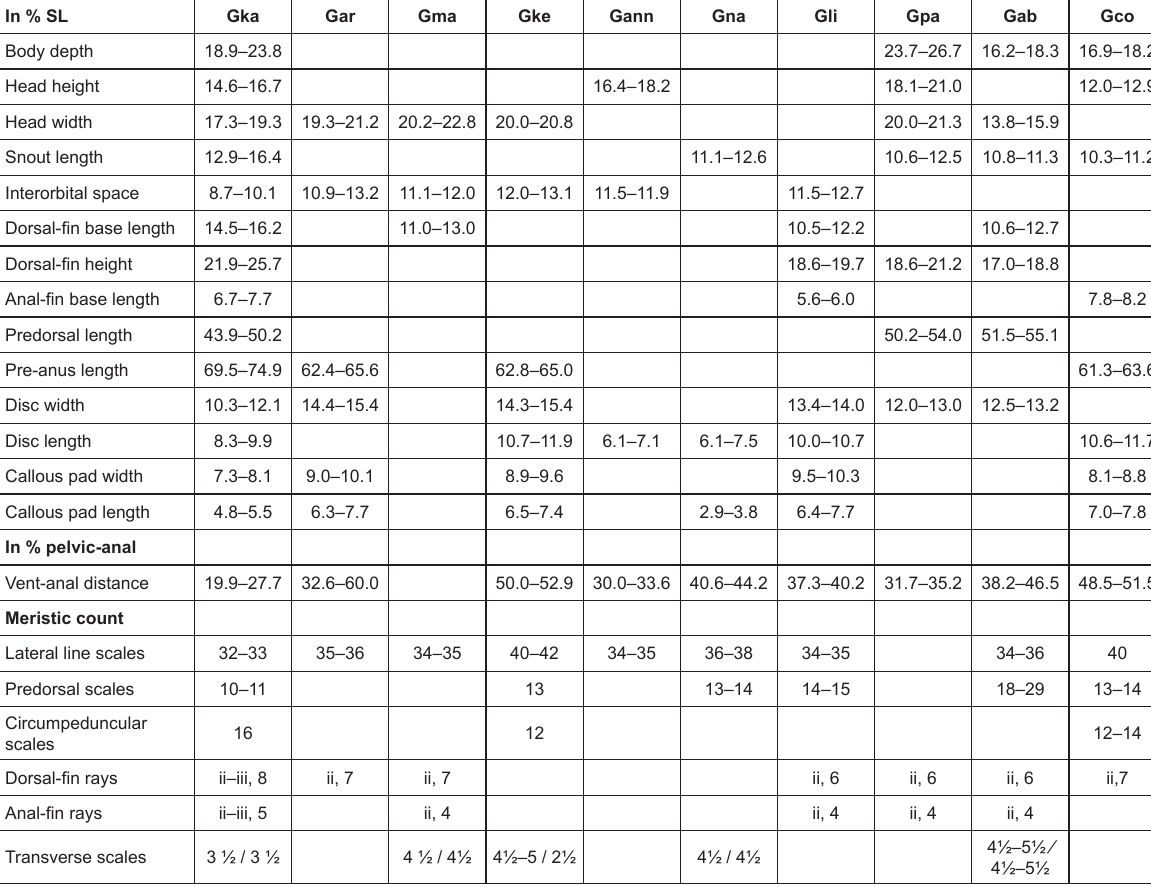
Table 2. Comparative morphometric data and meristic count of Garra kalpangi sp. nov. from its nine congeners. In %